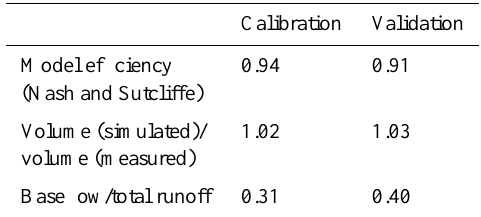
Table 2. Calibration and validaton results of WaSiM-ETH 8.4.2 at Gauge Greifenberg (A E =124km 2 ), Windach Catchment.